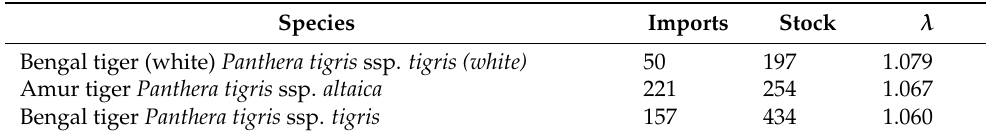
Table A1. Imported EN tiger ( Panthera tigris ) from 1996 to 2015 and present stock (2017) in China, with their respective finite rates of increase ( λ